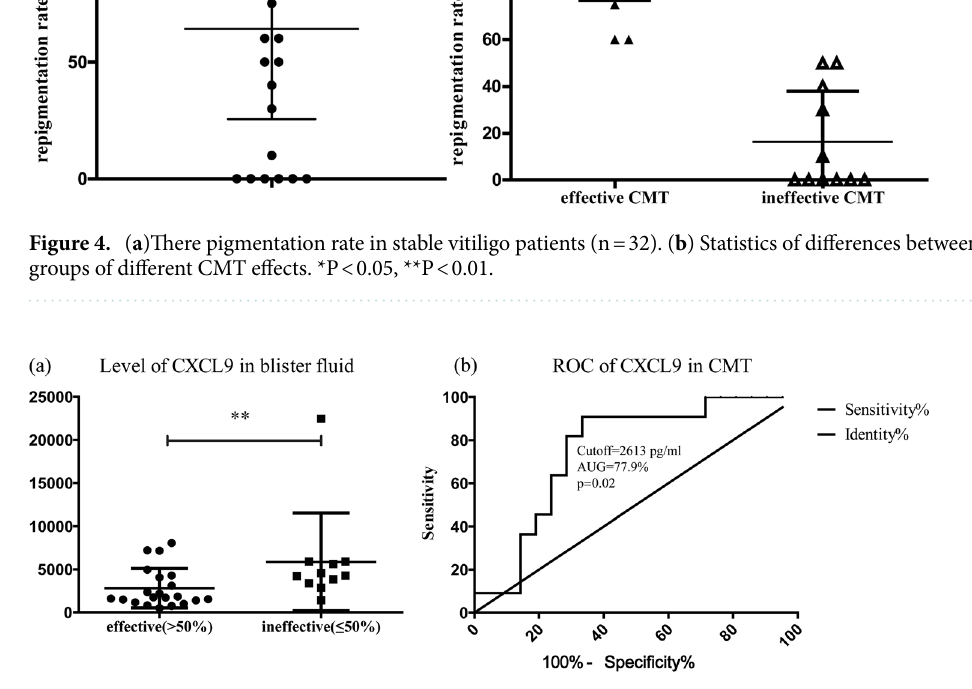
Figure 5. ( a ) The CXCL9 levels in blister fluid of patients with different treatment responses.( b ) ROC curve plotted to distinguish the cut-off value of CXCL9 levels among patients with different treatment responses. *P < 0.05, **P <